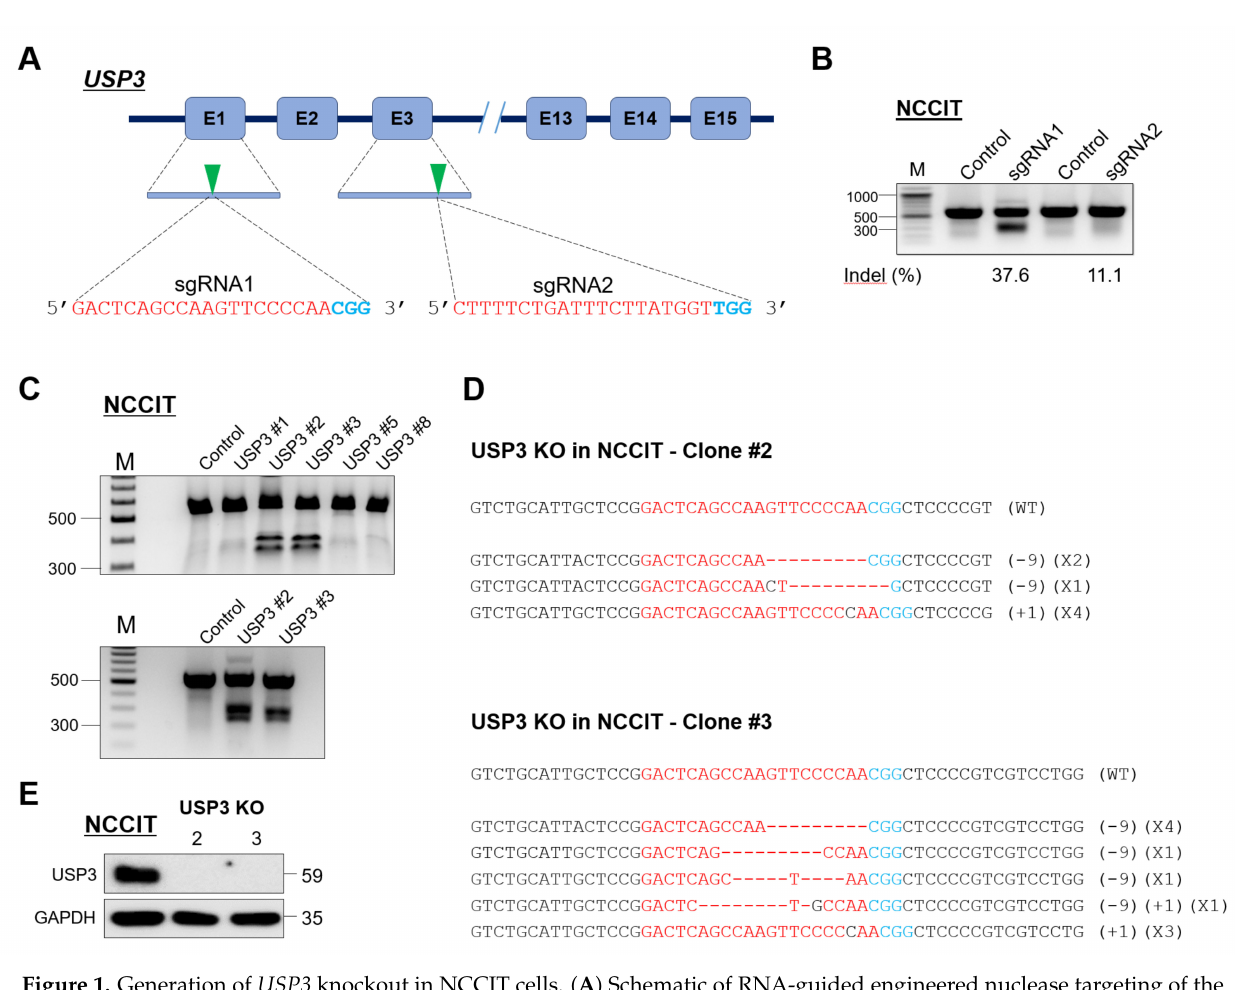
Figure 1. Generation of USP3 knockout in NCCIT cells. ( A ) Schematic of RNA-guided engineered nuclease targeting of the human USP3 gene using sgRNA1 and sgRNA2, which were designed to target sequences in exon 1 and exon 3, respectively. sgRNA target sequences are represented in red, and PAM sequences in blue. ( B ) T7E1 assays were performed in NCCIT cells to determine the cleavage efficiency of sgRNA1 and sgRNA2 by transfecting along with Cas9 plasmid. Samples were resolved in 2% agarose gel. The cleaved band intensity obtained from T7E1 assay were measured (indel %) using ImageJ software. Un-transfected NCCIT cells were used as control cells. A marker is shown for size reference. ( C ) USP3 knockout single-cell colonies were screened using the T7E1 assay (upper panel). The USP3 KO-positive clones, i.e., USP3 KO#2 and #3 were reconfirmed by T7E1 assay (lower panel). ( D ) USP3 gene-disrupted sequences obtained from Sanger sequencing, i.e., USP3 KO#2 (upper panel) and USP3 KO#3 (lower panel). The sgRNA recognition site is indicated in red, and the protospacer adjacent motif (PAM) is indicated in blue. Dashes indicate deleted bases, while inserted bases are represented in black. The number of deleted and inserted bases are mentioned in the parentheses; the numbers of occurrences of the indicated sequences are shown in parentheses (for example, X1 and X2 indicate the number of each clone sequenced). ( E ) USP3 knockout efficiency in NCCIT cells was checked by Western blot analysis for USP3 KO clones #2 and #3 using the USP3-specific antibody. GAPDH was used as loading